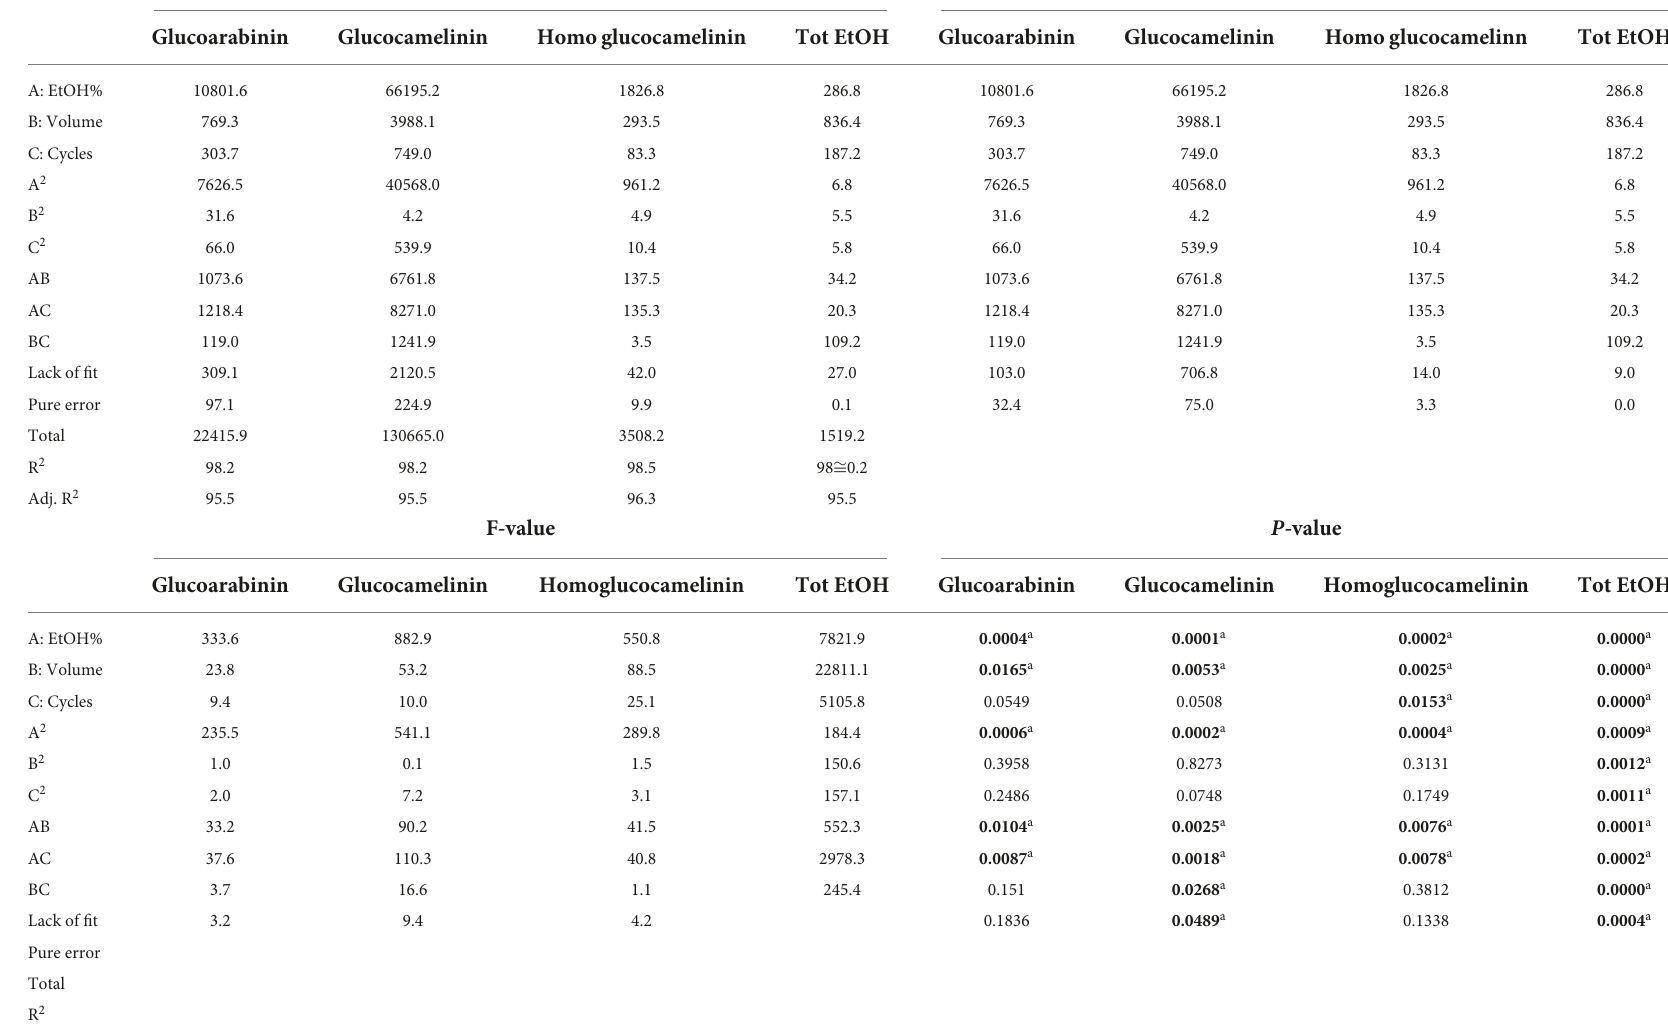
TABLE 2 Analysis of variance of the regression